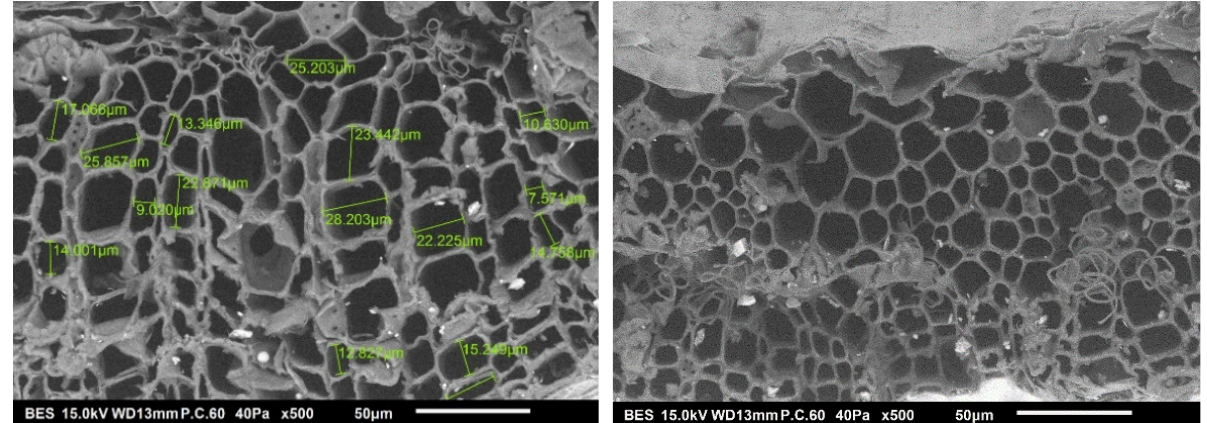
Figure 3. SEM picture of flax shives showing a cellular morphology.